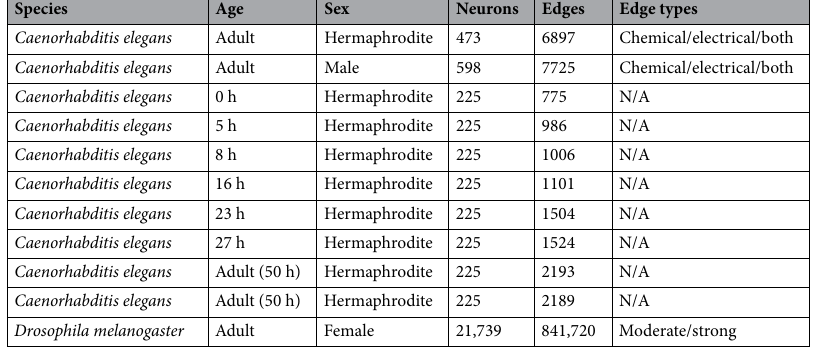
Table 1. Connectome datasets. We enumerate subgraphs on eleven connectomes from two different species. Two of the adult C. elegans connectomes also contain end-organs and